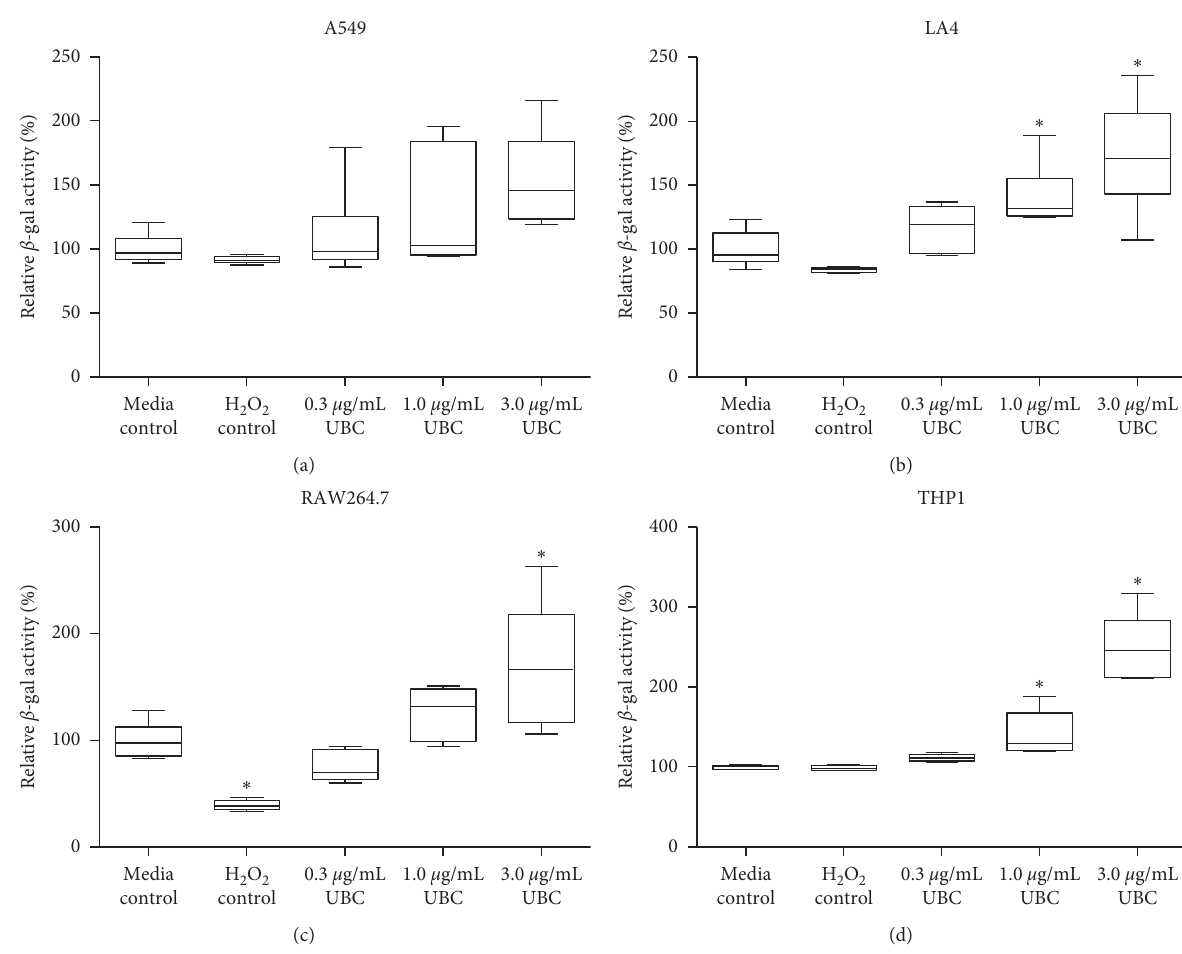
Figure 6 : UBC promotes cellular senescence, enhancing beta-Galactosidase ( β -Gal) activity in a dose-dependent manner for all cell lines. Cells were seeded on day zero then treated with various concentrations of UBC for 9 days. Following subsequent treatments, the cells were harvested and assessed for cellular dormancy following the manufacturer’s instructions for the mammalian β -Galactosidase kit ( β -Gal Senescence, Colorimetric Assay). Data normalized to the media control and displayed as the mean of six replicates ± max and min values. Data are indicated as one of three representative independent experiments. Statistically significant at ∗ p < 0 . 05 in comparison to untreated media controls. (a). A549, (b). LA4, (c). RAW264.7, (d).